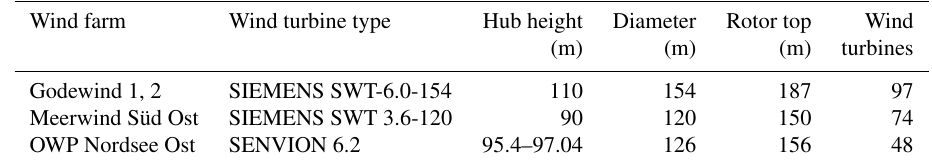
Table 3. Wind turbine types installed at the measurement sites according to the data of the Bundesnetzagentur (2019). Wind